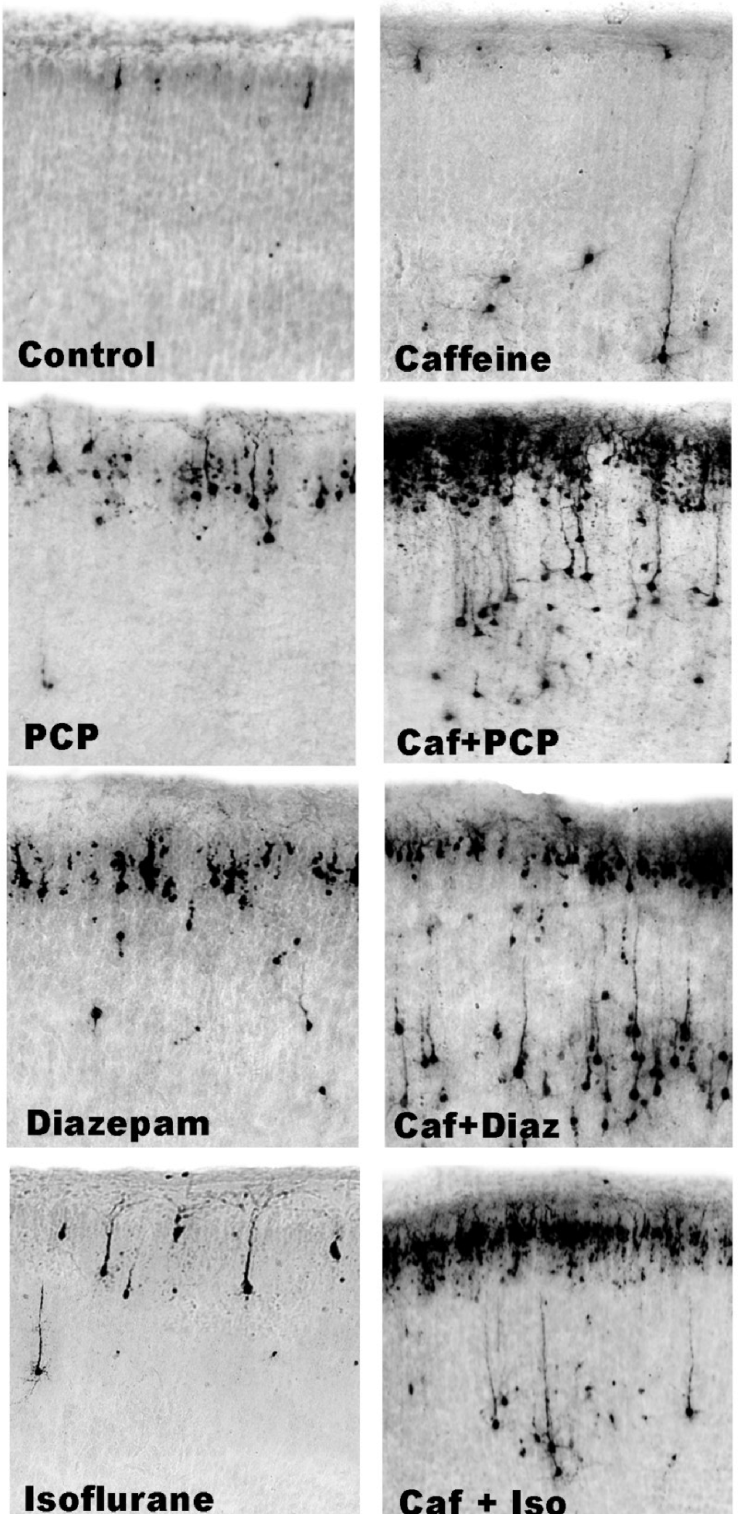
Figure 6. Neuroapoptosis in the Neocortex. These detail views reveal that combining caffeine with PCP, diazepam or isoflurane causes a marked increase in the density of apoptotic profiles in the superficial cortical layers, and also causes spread of the cell death reaction to include the deeper cortical